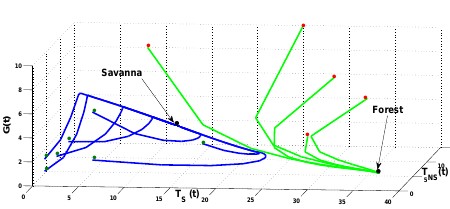
Fig. 3. 3D plot of the trajectories of system (1) showing that the forest ( E T ) and savanna ( E TG ) equilibria are stable. The green and red bullets represent di ff erent initial conditions.